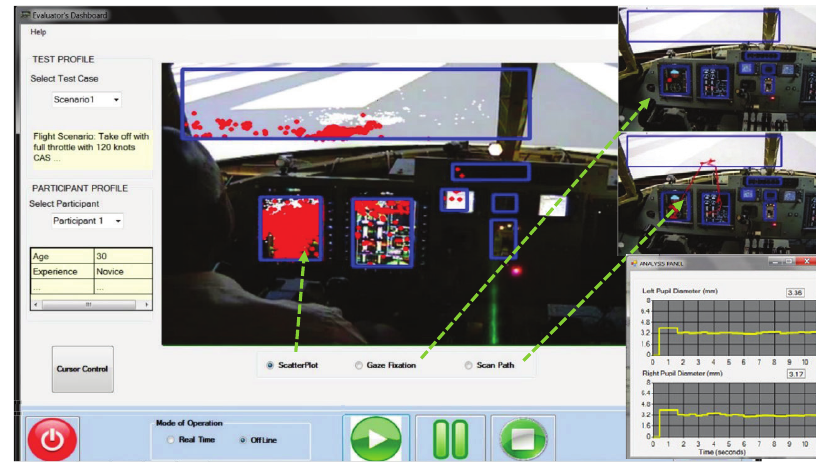
Figure 14. Evaluator’s